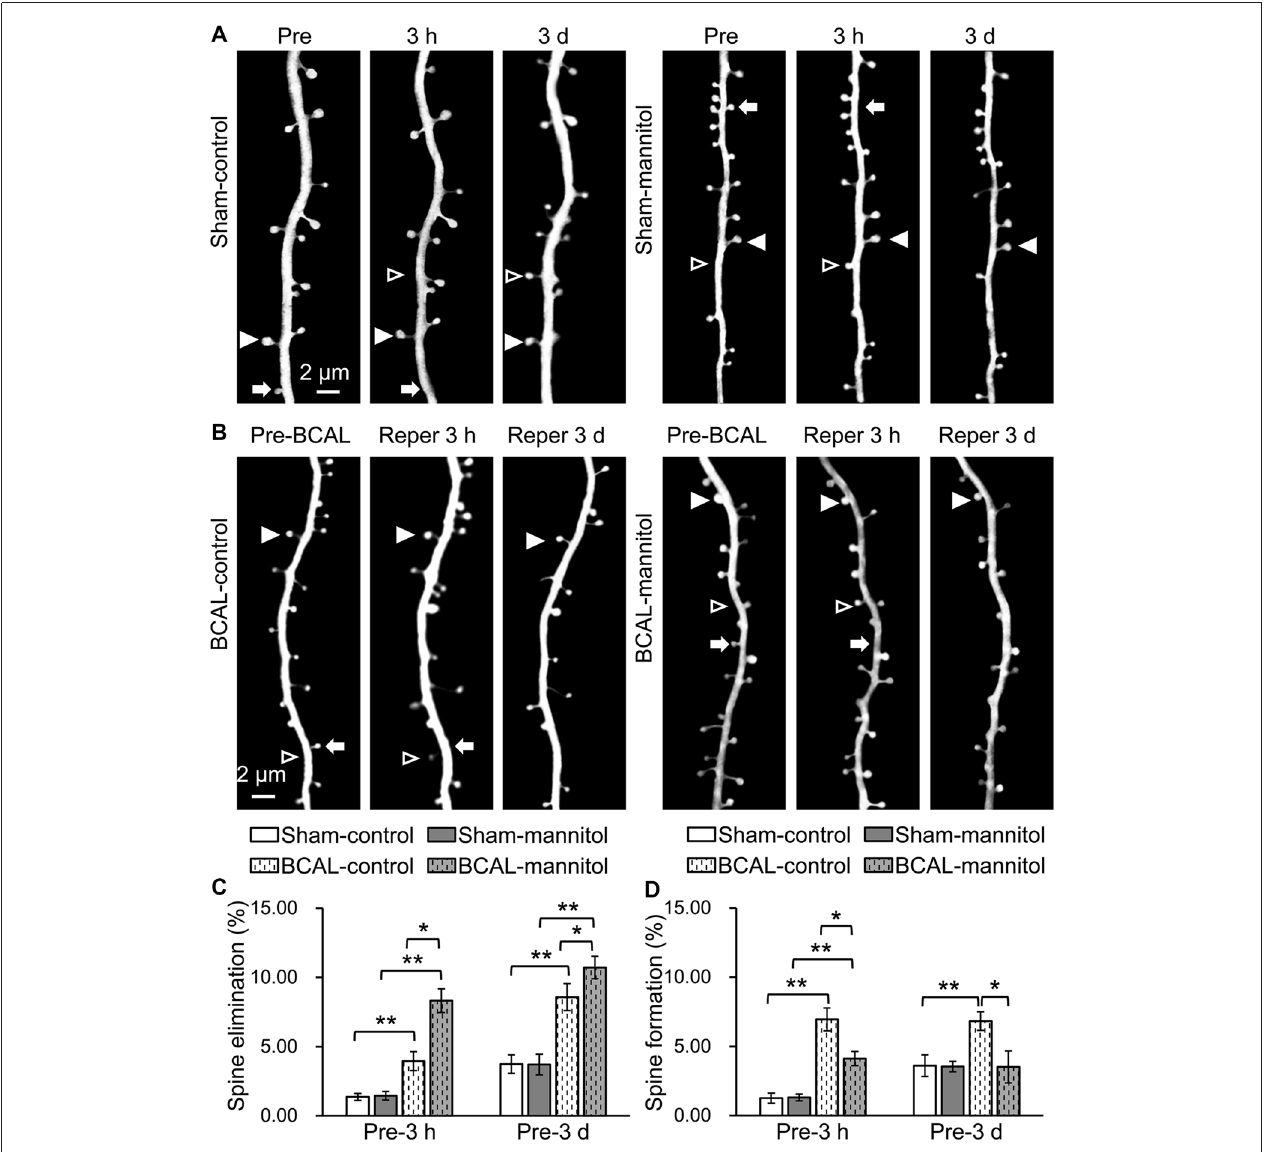
FIGURE 5 | Mannitol-induced changes in spine formation and elimination following reperfusion after transient global cerebral ischemia. (A,B) Time-lapse imaging of dendritic structures showing spine formation or elimination in sham-control mice, sham-mannitol mice, BCAL-control mice and BCAL-mannitol mice. Open arrowheads, arrows and filled arrowheads indicate newly formed spines, eliminated spines and stable spines, respectively. (C) Spine elimination rate and (D) spine formation rate were significantly higher in BCAL-control than that of sham-control mice at 3 h and 3 days after reperfusion ( n = 6 mice, each group. ∗ p < 0.05 and ∗∗ p < 0.01) and there were no significant changes in spine elimination rate and spine formation rate between sham-control mice and sham-mannitol mice at 3 h and 3 days ( n = 6 mice, each group. p > 0.05). Note that spine elimination rate is significantly higher, but formation rate is significantly lower in BCAL-mannitol mice than that in BCAL-control mice at both 3 h and 3 days after reperfusion ( n = 6 mice, each group. ∗ p < 0.05 and ∗∗ p < 0.01).